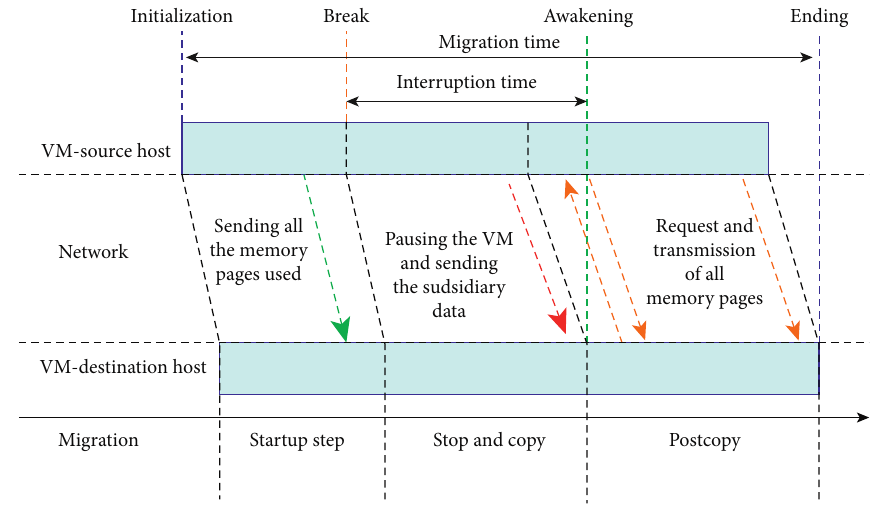
Figure 8: Hybrid postcopy